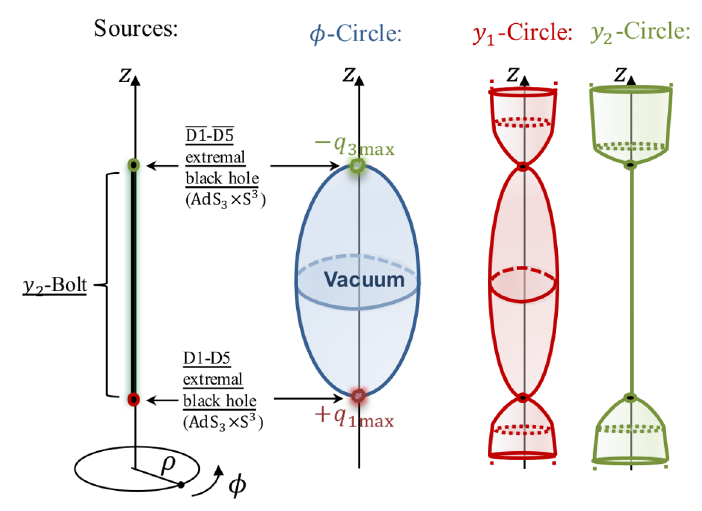
Figure 1 . Bound state of BPS D1-D5 branes and anti-BPS D1-D5 anti-branes separated by a bolt, corresponding to two extremal D1-D5 black holes with charges of opposite sign, held apart by a vacuum bubble. We have represented the profile of the sources and topology on the z -axis of the T 2 circles, y and y , and the circle of symmetry of the three-dimensional base, φ 1 2